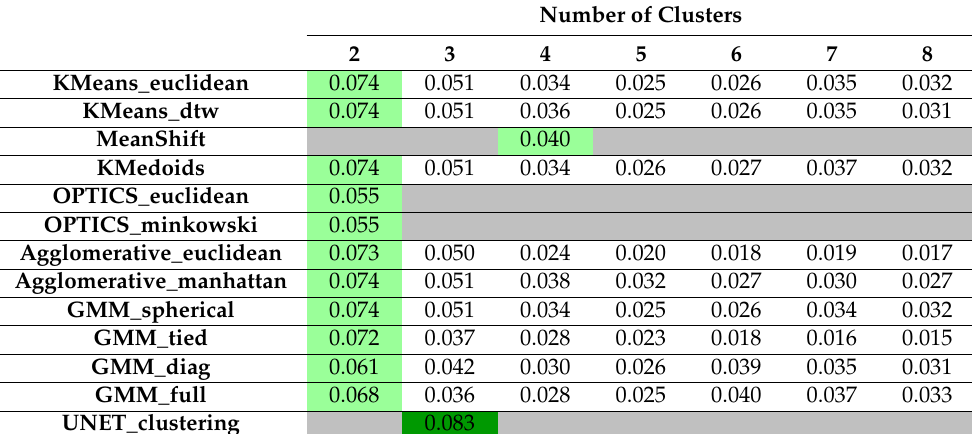
Table 3. Shape score σ j clusters.